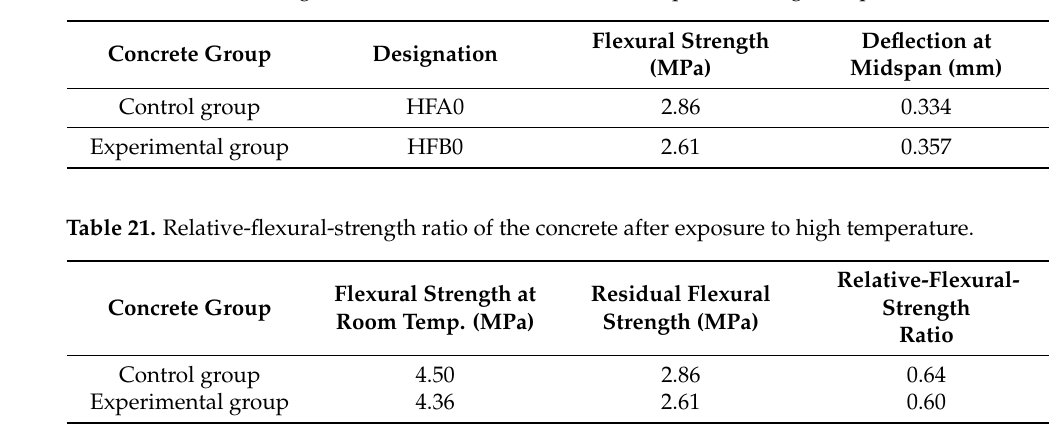
Table 20. Flexural strength test results of the concrete after exposure to high temperature.